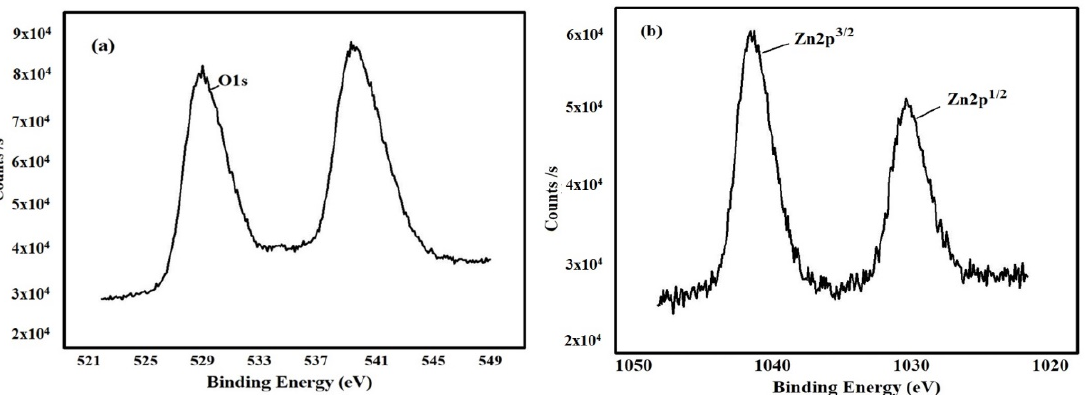
Figure 9. The X-ray photoelectron spectroscopy for ZnONP synthesized suing C. cuspidatus , ( a ) O1s binding energy area ( b ) Zn2p binding area.